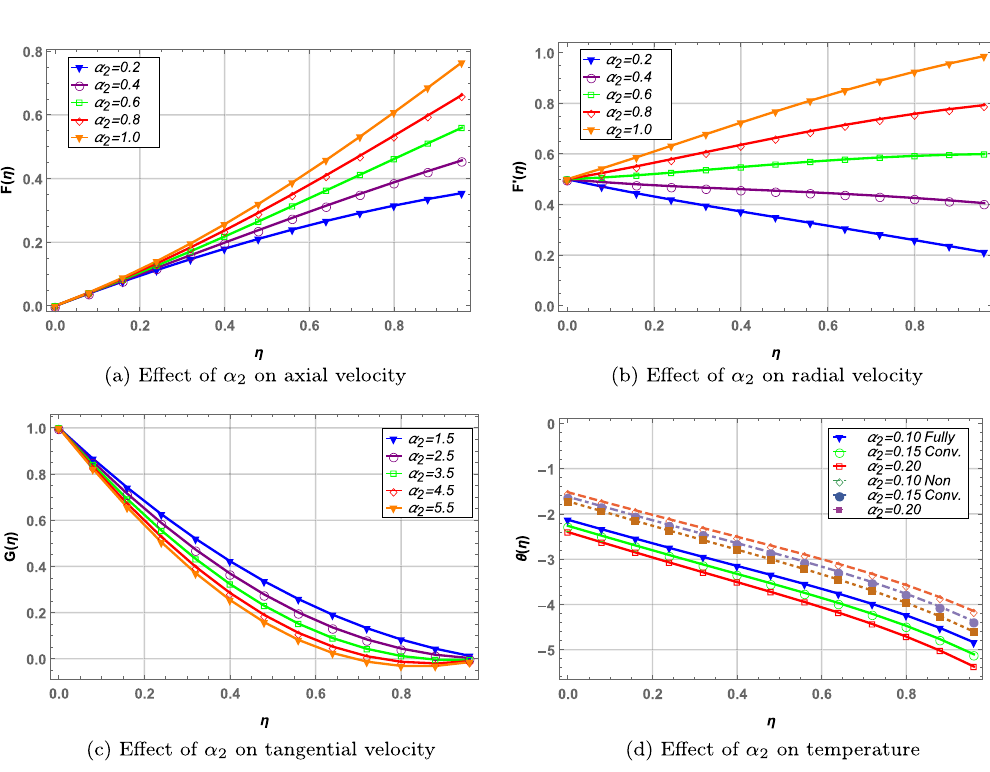
Figure 7. Effect of unsteady parameter on velocity, temperature and concentration